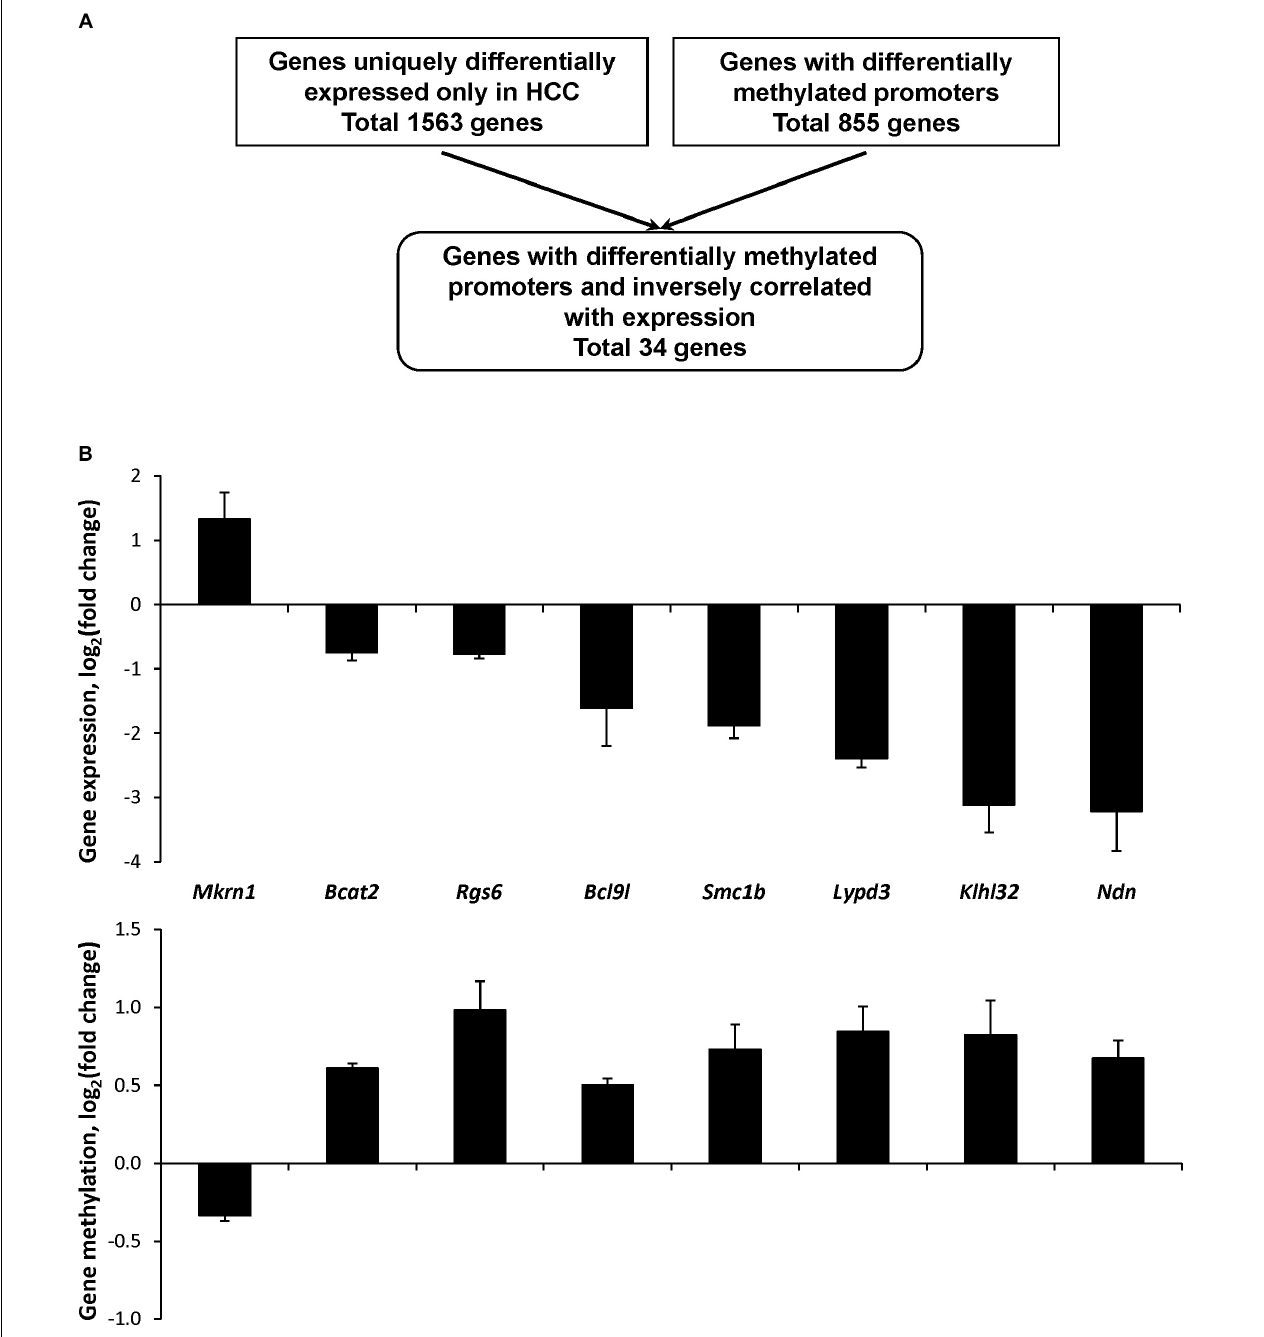
FIGURE 4 | Expression and promoter DNA methylation of uniquely differentially expressed CpG island-containing genes in HCC in STAM mice at 20 weeks. (A) Algorithm for the selection of genes in HCC with differentially methylated promoters and inversely correlated with gene expression. (B) Gene expression and promoter DNA methylation of the selected genes differentially expressed in HCC. The results of gene expression and DNA methylation are presented as an average log 2 fold change in the livers of mice with full-fledged HCC relative to respective values of age-matching control mice, which were assigned a value